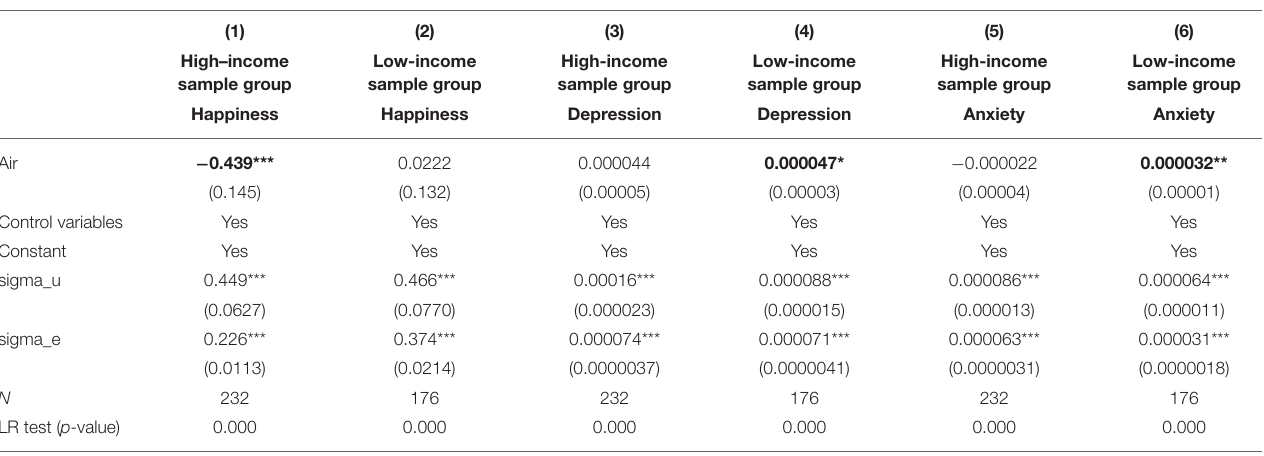
TABLE 9 | Regression results of air pollution on mental health with different income